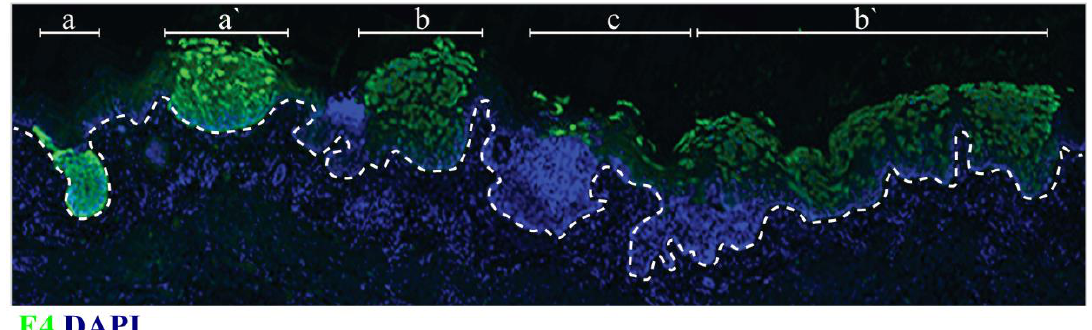
Figure 2. Viral gene-expression in adjacent Betapapillomavirus lesions. Immunostaining for the Betapapillomavirus E4 protein ( green ) reveals distinct patterns of expression in different lesions in an immunosuppressed individual. Lesion ( a ) and ( a´ ) are atypical, and show marked basal and suprabasal staining; This pattern of E4 expression is distinct from typical E4 pattern of expression, which is usually restricted to the mid/upper epithelial layers as seen in region ( c ); Lesions ( b ) and ( b´ ) show an intermediate pattern of E4 staining with expression close to the basal layer, as well as in the suprabasal cell layers (see also review [11]).